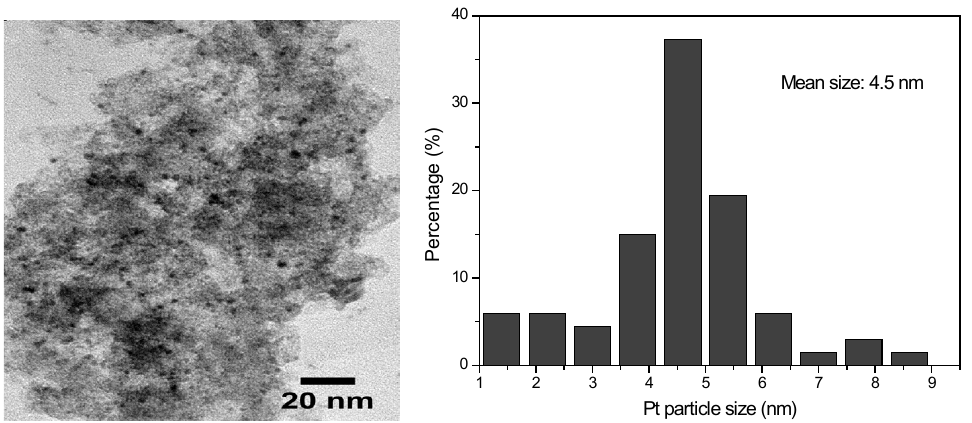
Figure 2: TEM image and particle size distribution of the Pt/C catalyst.